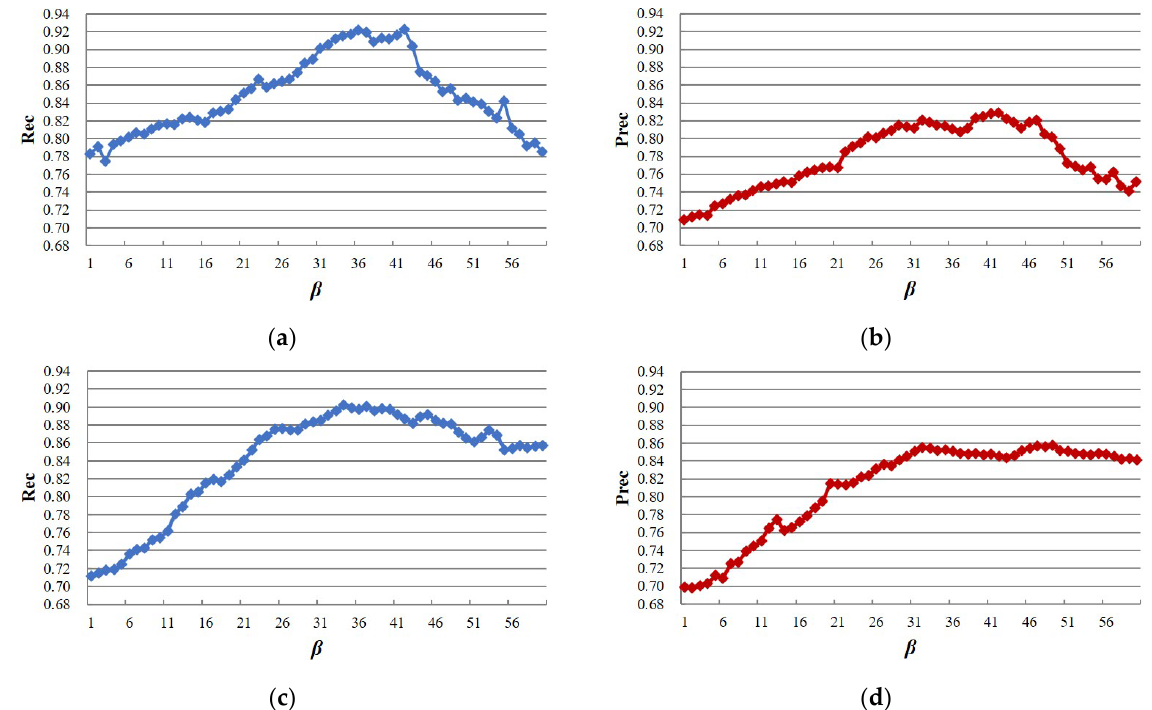
Figure 13. Experiments of the OMRF model with different values of β . ( a ) Rec of Figure 11a with different β ; ( b ) Prec of Figure 11a with different β ; ( c ) Rec of Figure 11f with different β ; ( d ) Prec of Figure 11f with different β .